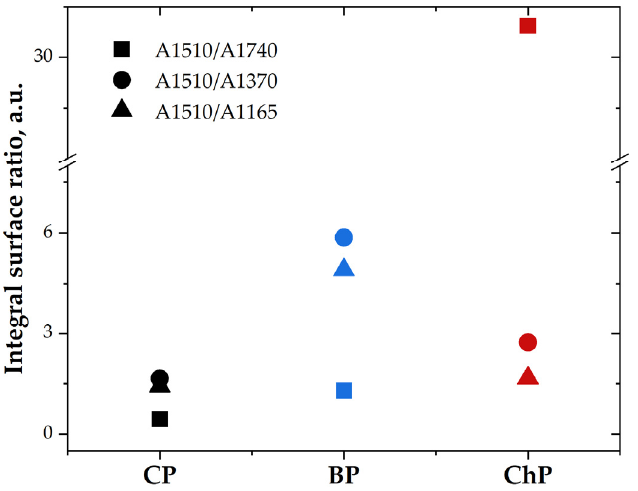
Figure 2. The integral surface ratio of 1510 cm − 1 band versus 1740, 1370 and 1165 cm − 1 bands; CP—contemporary sound pine, BP—biologically degraded pine, ChP—chemically degraded pine.